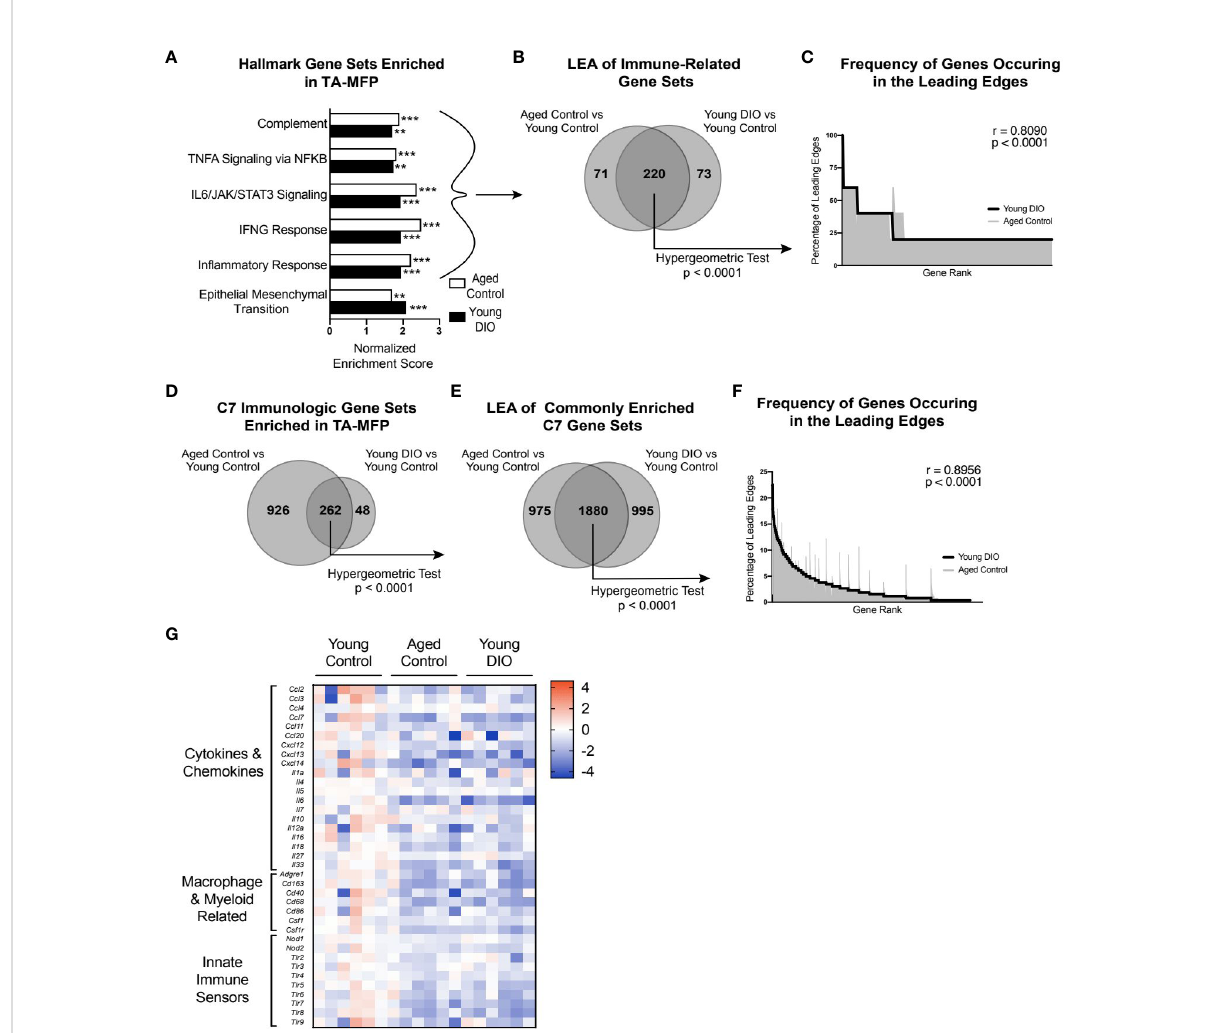
FIGURE 2 Advanced age and DIO induce convergent in fl ammatory alterations within the tumor-adjacent mammary adipose in a metM-Wnt lung cell transplant model of TNBC. (A) Hallmark gene sets commonly enriched in tumor-adjacent mammary fat pad (TA-MFP) of aged control versus young control and young DIO vs young control mice determined following gene set enrichment analysis (GSEA). (B) Leading edge analysis (LEA) of immune-related Hallmark gene sets commonly enriched. (C) Frequency of genes occurring in the leading edge of commonly enriched, immune-related Hallmark gene sets versus gene rank. (D) C7 Immunologic gene sets commonly enriched in TA-MFP of aged control vs young control and young DIO vs young control micedetermined following GSEA. (E) LEA of all C7 gene sets commonly enriched. (F) Frequency of genes occurring in the leading edge of commonly enriched C7 gene sets versus gene rank. (G) Heat map of select leading edge genes. Signi fi cantly enriched gene sets de fi ned as FDR q-value <0.05. Signi fi cance in overlap of leading edge genes analyzed using hypergeometric test. Correlation between the gene rank of leading